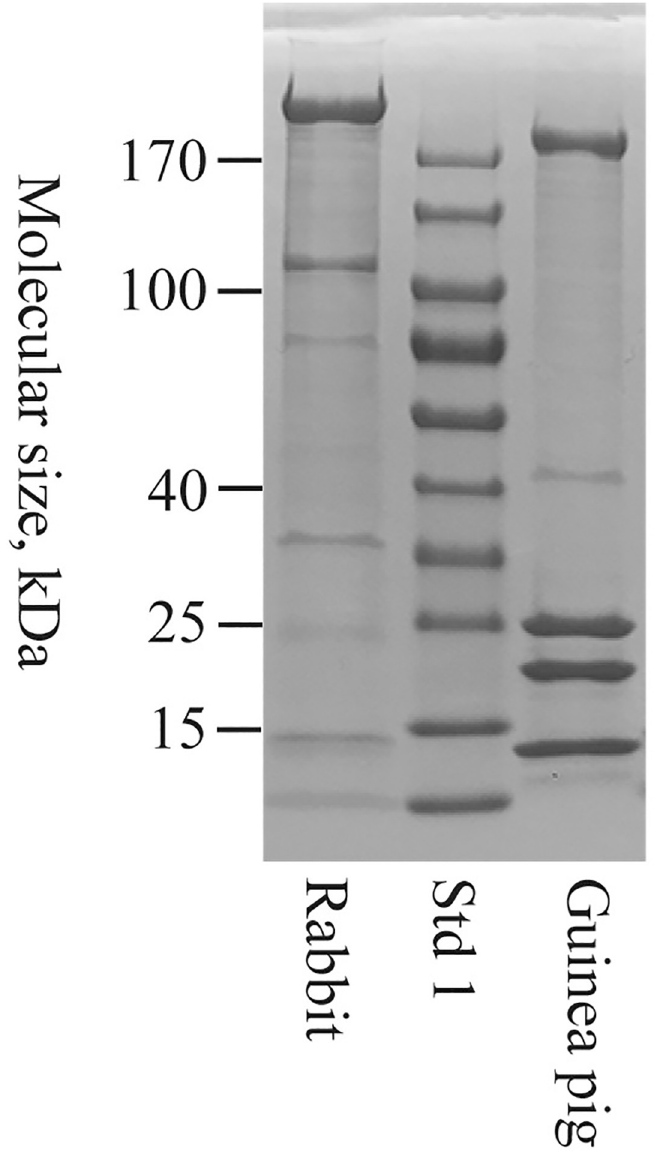
Fig 1. Analysis of seminal vesicle secretion by SDS-PAGE. Guinea pig and rabbit sample, equivalent with 0.1–0.2 μ l seminal vesicle secretion, were reduced and run on a 4–20% gradient SDS-PAGE gel run in Tris-Glycine buffer, pH 8.3. Std 1 refers to the molecular mass standard Page